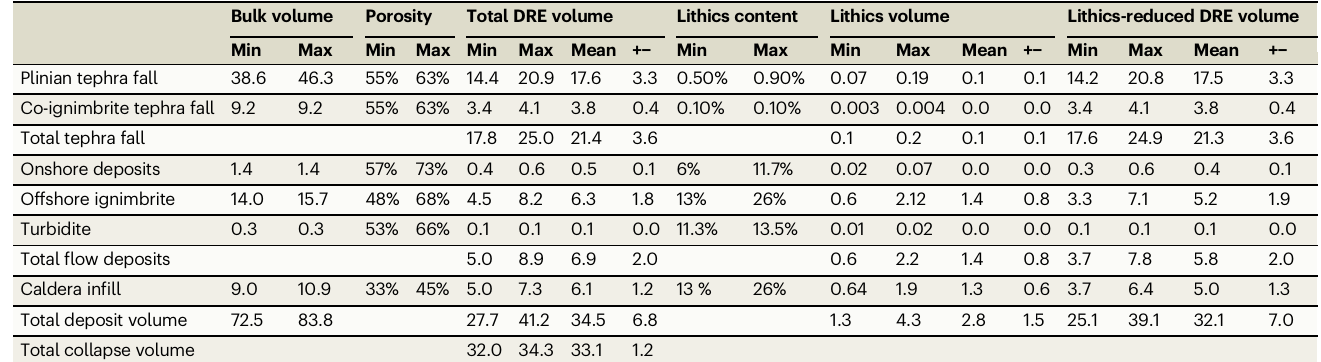
Table 1 | Volume estimates for the various components of the Minoan eruption deposits